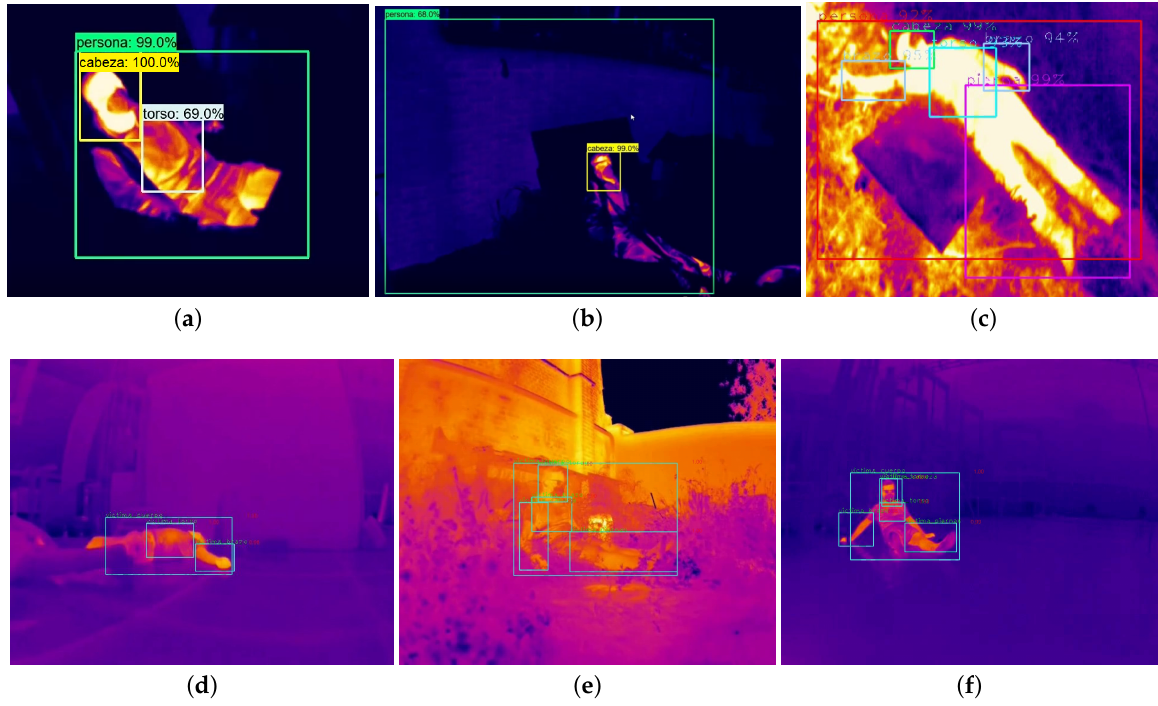
Figure 13. Examples of victim detection with Faster R-CNN, SSD, and YOLOv3. The efficiency in the detection of victims respectively is a = 99%, b = 60%, c = 98%, d = 97%, e = 96%, and f = 99%. ( a ) Faster R-CNN, ( b ) SSD, ( c ) YOLOv3 (Day outdoor), ( d ) YOLOv3 (Day indoor), ( e ) YOLOv3 (Day outdoor), and ( f ) YOLOv3 (Night indoor). Source: